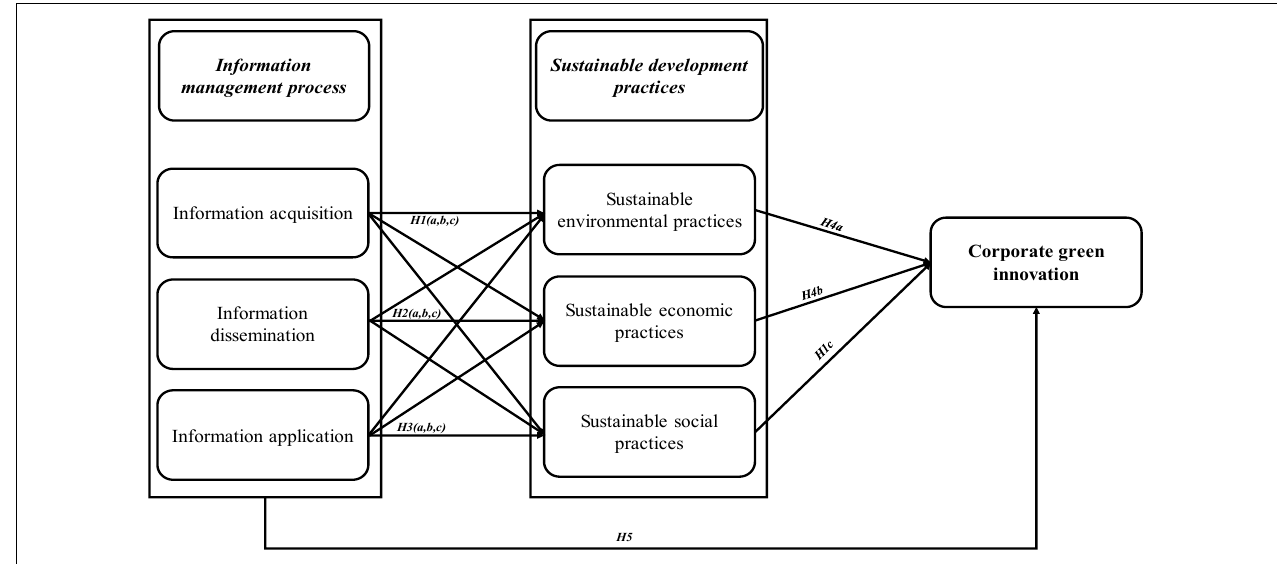
FIGURE 1 | Research